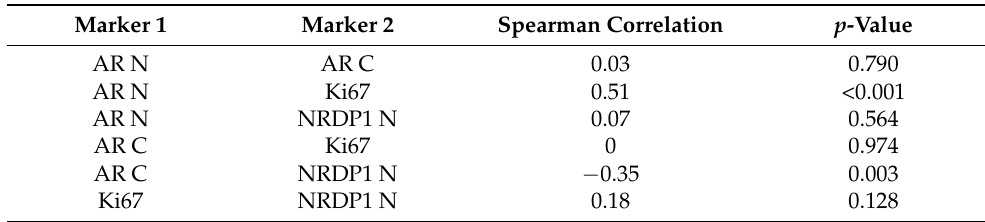
Table 5. Correlations between AR, NRDP1, and Ki67 expression in prostate cancer tumor cells from patients with stage 3 disease. N, nuclear localization; C, cytoplasmic localization. Bolded font denotes statistically significant